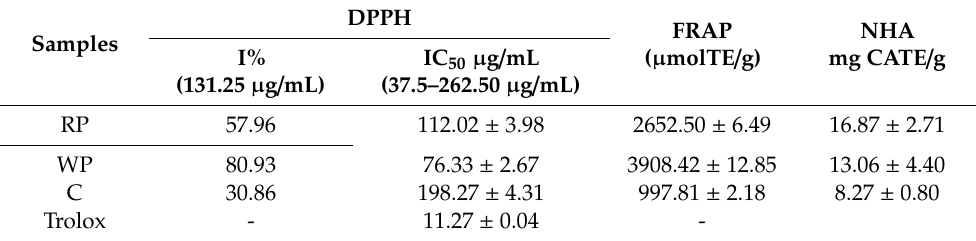
Table 5. Antioxidant activity of studied